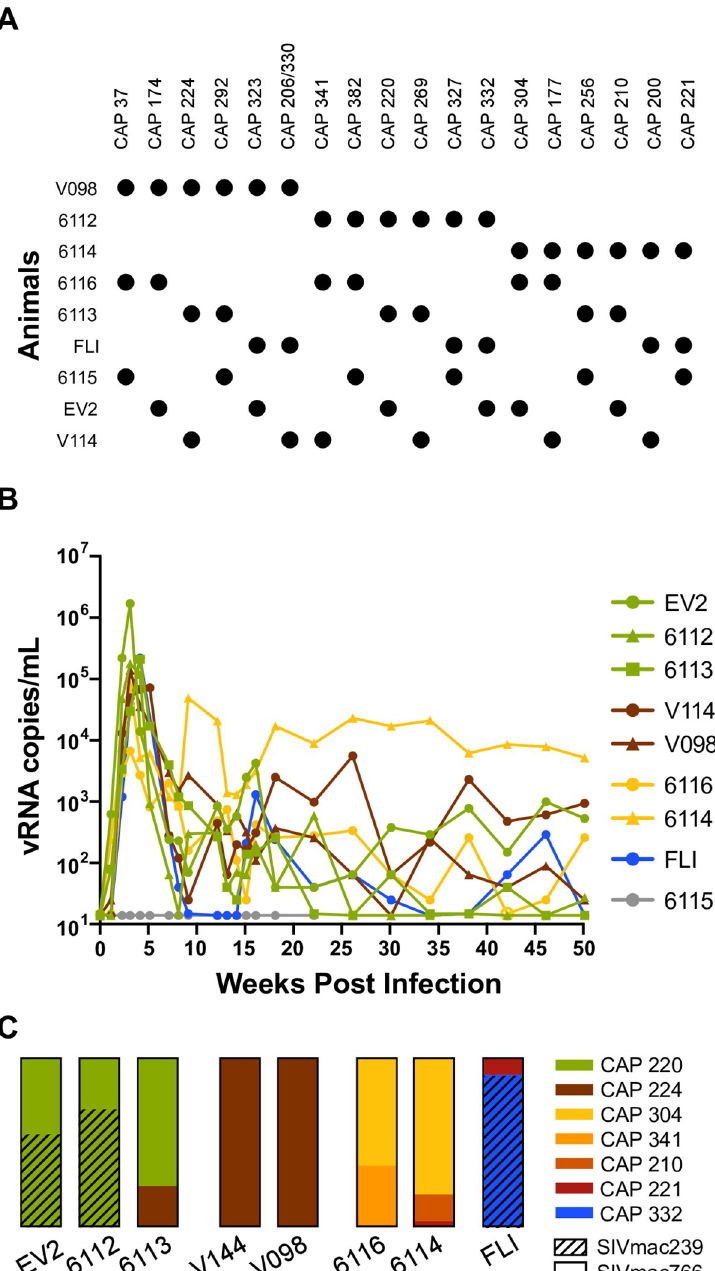
Fig 2. Pooled inoculation strategy and in vivo replication of subtype C SHIVs. (A) Nineteen unique SHIVs were grouped into 9 pools with 6 variants in each pool. Each variant was represented in 3 pools, and pairs did not occur more than twice. Virus inocula contained SHIVs based on either the SIVmac239 or SIVmac766 backbone in equal proportion except for CAP206 239 and CAP330 766 for which only one backbone was available. Infectious titer determined on TZM-bl cells for each SHIV was used to generate virus pools containing equal amounts of each constituent SHIV. (B) Plasma viral load in 9 rhesus macaques intravenously inoculated with the pooled SHIVs. (C) In vivo proportions of each clone at peak viremia in plasma were assessed by sequence analysis and are represented by stacked bar graphs. SHIVs with SIVmac766 backbone are shown in solid and those with a SIVmac239 backbone are shaded. Colors in VL graph correspond to the clone of highest frequency in that